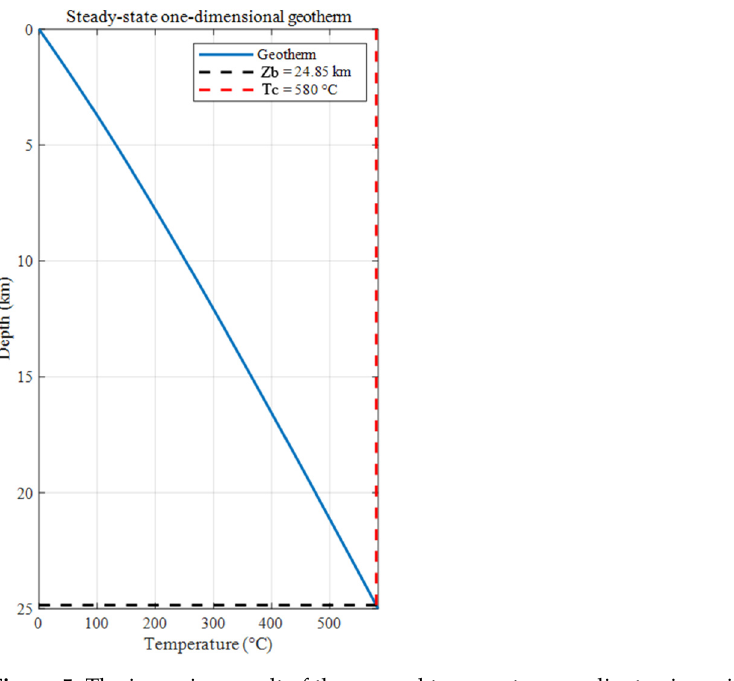
Figure 5. The inversion result of the ground temperature gradient using window 3 as an example.